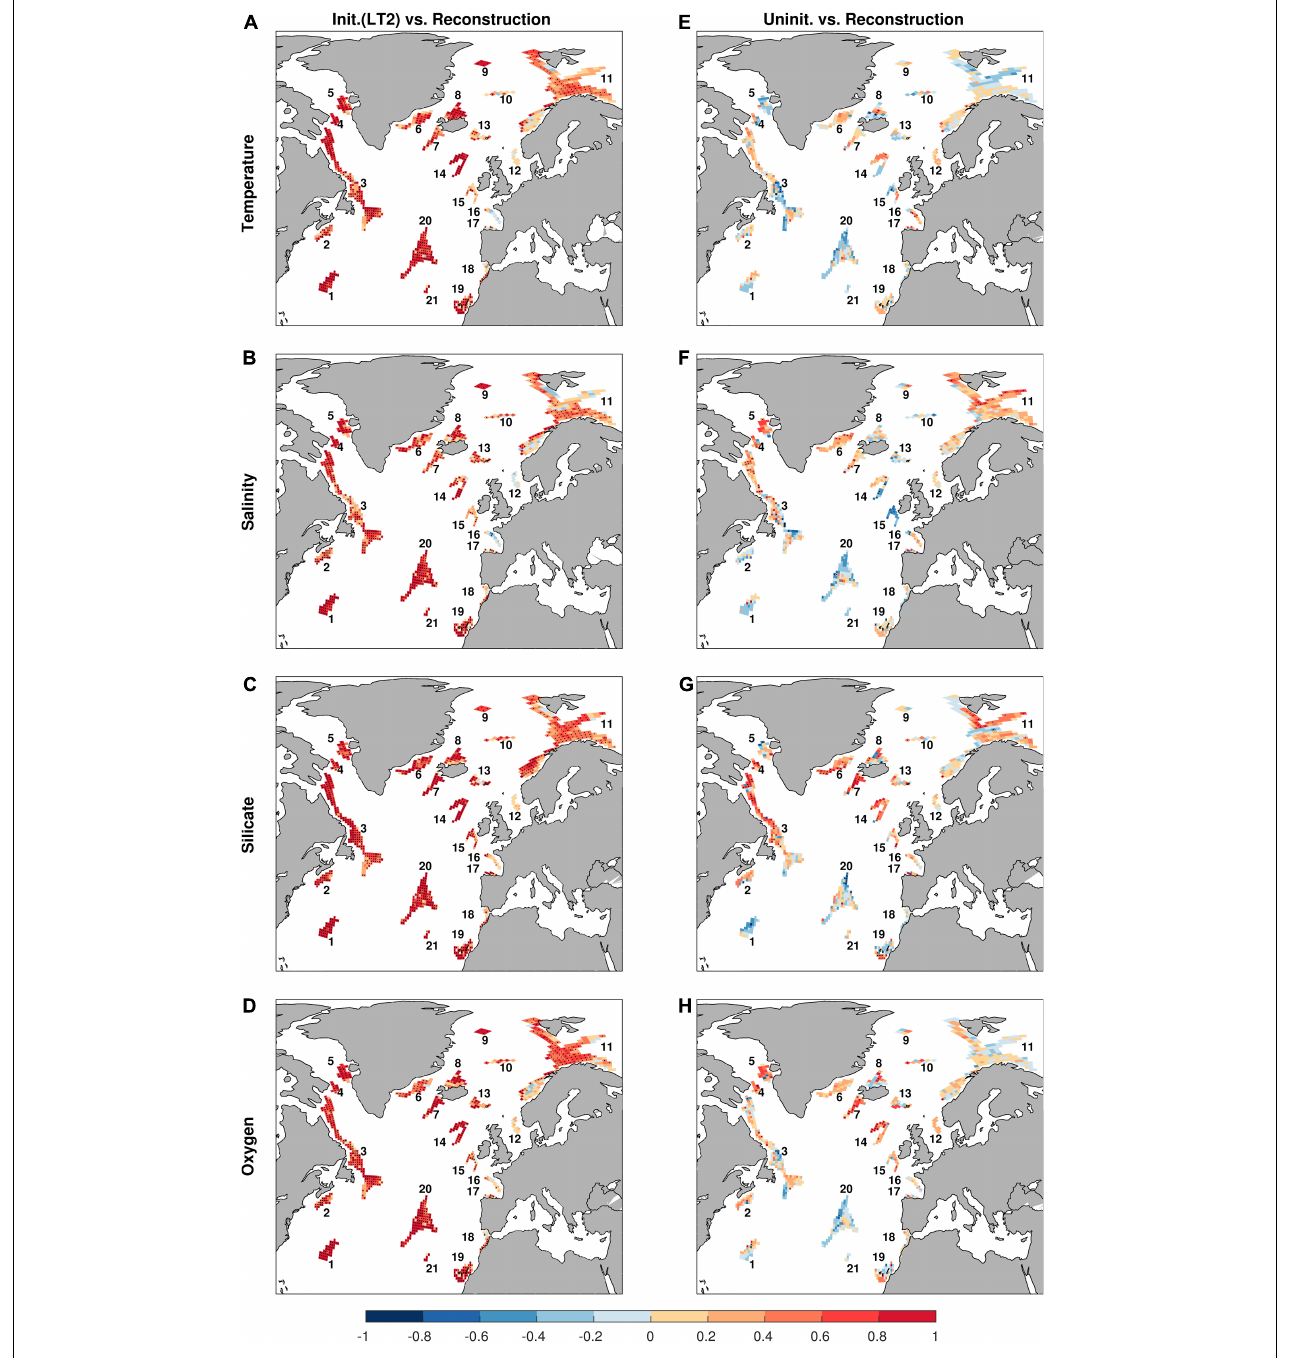
FIGURE 4 | Anomaly correlation coefficients (ACCs) for temperature (A,E) , salinity (B,F) , silicate (C,G) , and oxygen (D,H) . Left column (A–D) : correlations between the initialized simulations at a lead time of 2 years and the reconstruction. Right column (E–H) : correlations between the uninitialized simulations and the reconstruction. Stippling denotes statistically significant correlations at the 95% level based on a bootstrap approach with 500 bootstrapped